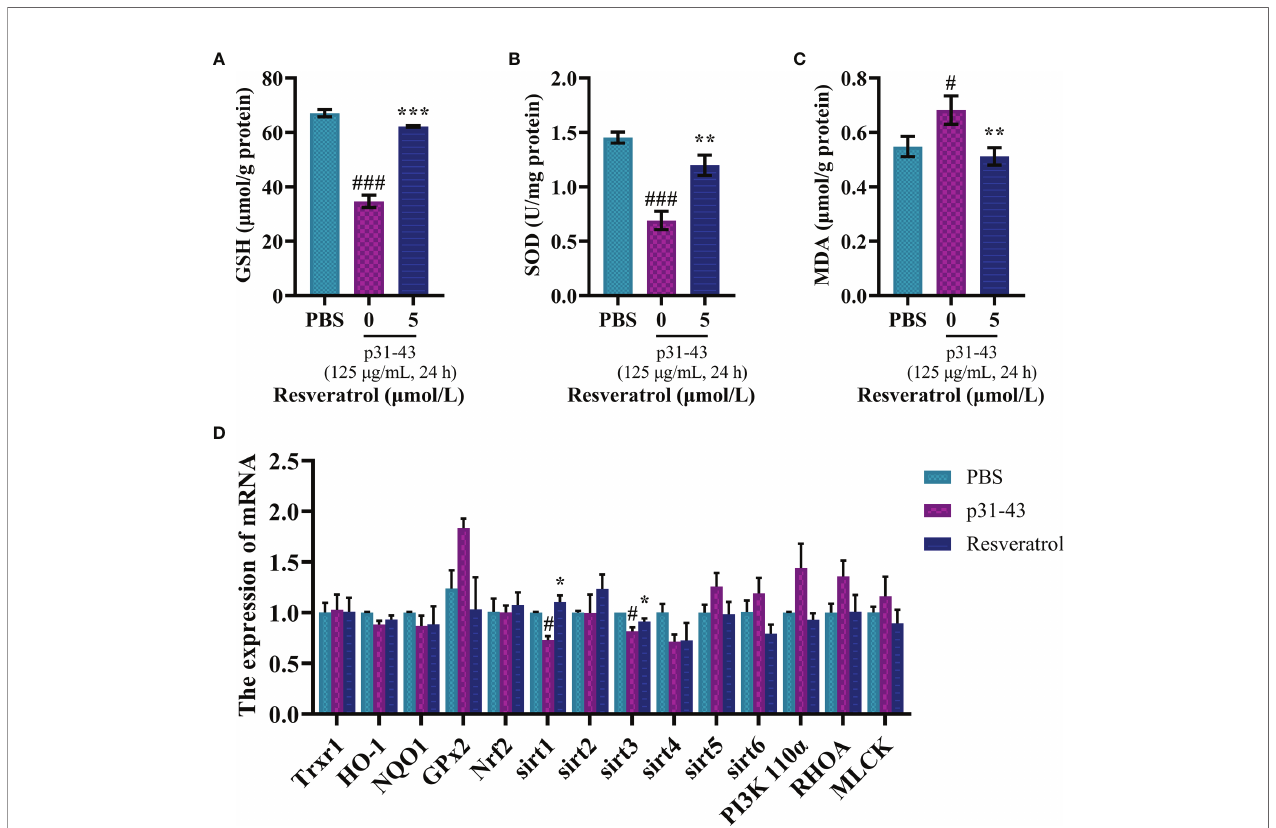
FIGURE 1 | Resveratrol mitigated damage from oxidative stress in cell model for celiac disease. (A) GSH content. (B) Enzymatic activity of SOD. (C) MDA content. (D) Expression of antioxidant gene. # Indicated statistically signi fi cant differences when compared to the PBS group. # P < 0.05; ### P < 0.001. * Indicated statistically signi fi cant differences when compared to the p31-43 group. *P < 0.05; **P < 0.01; ***P <